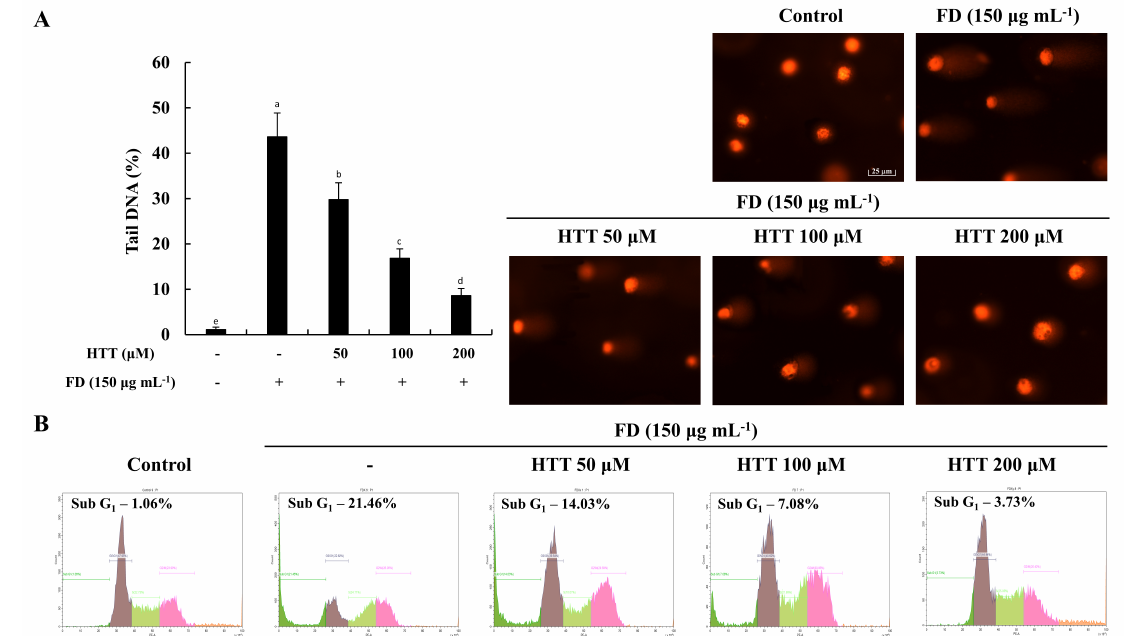
Figure 3. (–)-loliolide (HTT) inhibited DNA breakage and apoptosis in fine dust (FD)-stimulated HaCaT cells. ( A ) Comet tails and ( B ) sub-G 1 cell populations of FD-stimulated HaCaT cells treated with HTT. Cells were treated with di ff erent concentrations of HTT (50–200 µ M) prior to stimulation with FD. Comet tail DNA percentages were analyzed using the OpenComet plugin of the ImageJ software. Results were analyzed as three independent determinations ( n = 3) to confirm repeatability. Values are given as means ± SEM, and error bars representing di ff erent letters are significantly di ff erent ( p <